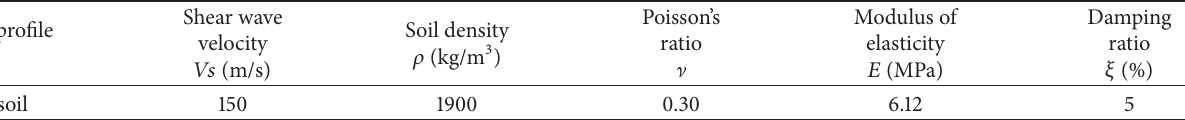
Table 1: Parameters of the